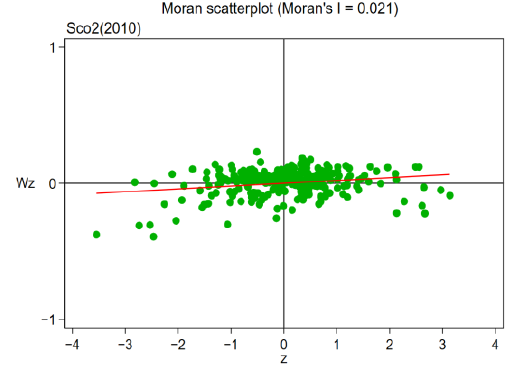
Figure 10. Moran Scatterplot (2010).